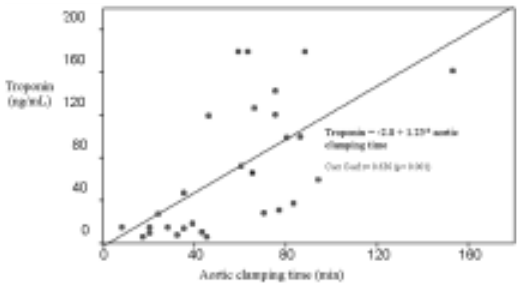
Fig. 5 – Correlation between the aortic clamping time and troponin I (time interval